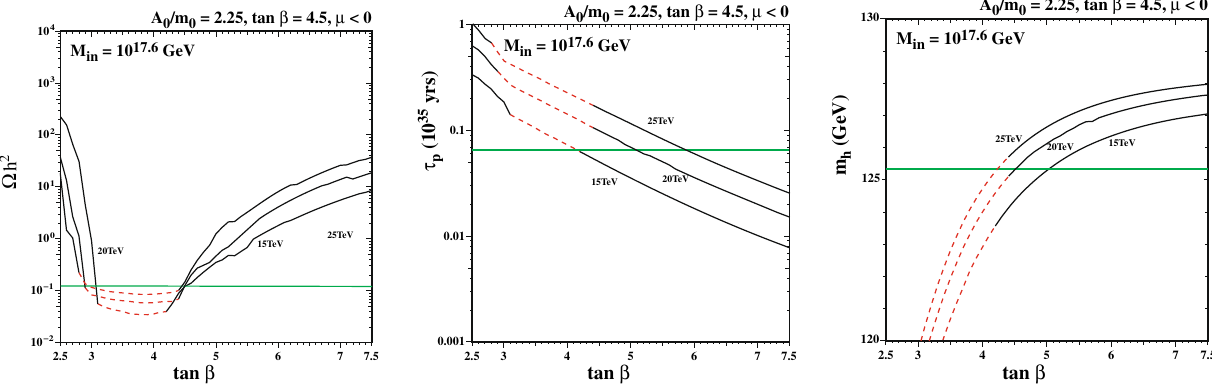
M in = 10 17.6 GeV